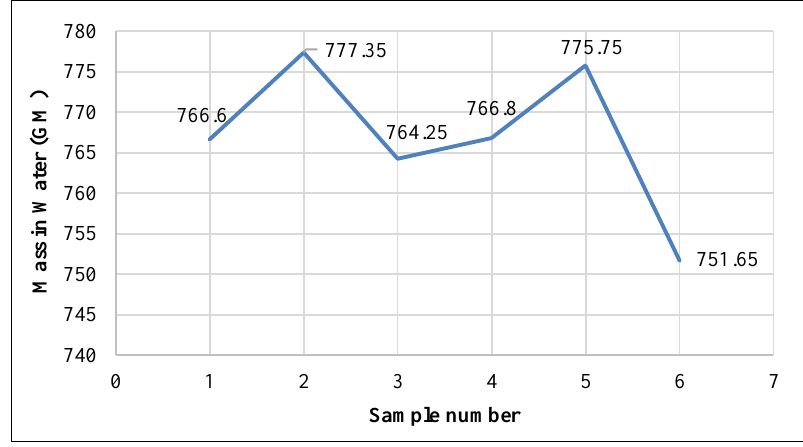
Figure 22. Mass in water values for six